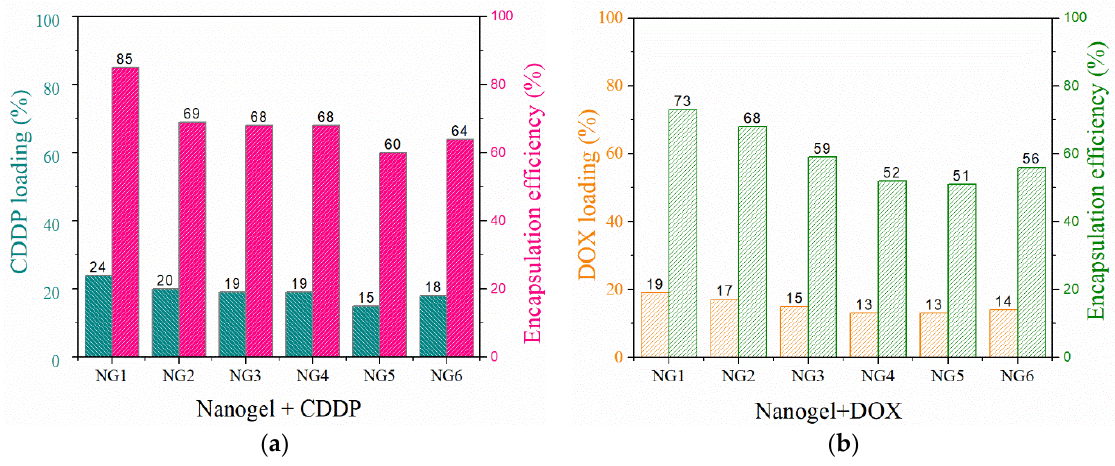
Figure 2. Drug loading and encapsulation efficiency of drugs in nanogels: ( a ) CDDP, ( b ) DOX.